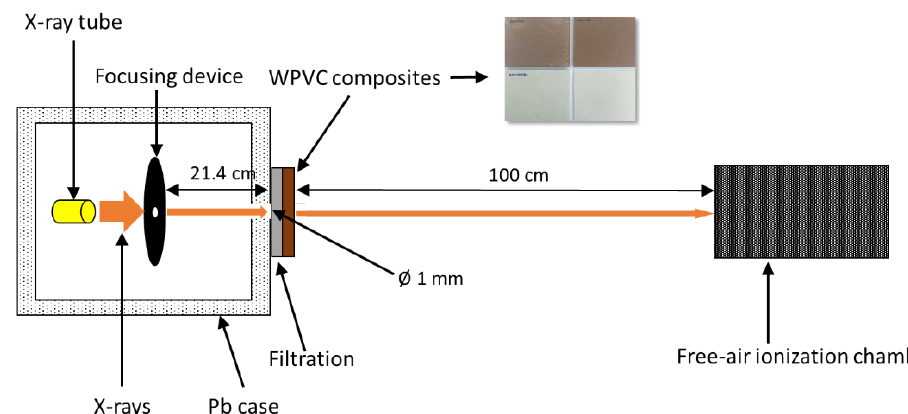
Figure 2. Experimental setup for X-ray shielding measurement.